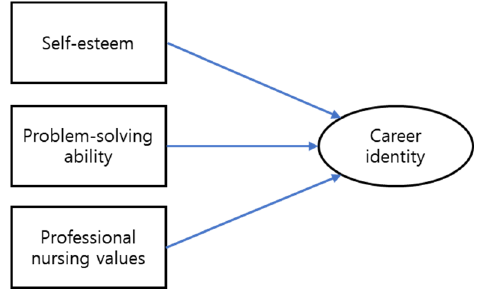
Figure 1. A hypothetical model for factors affecting career identity.